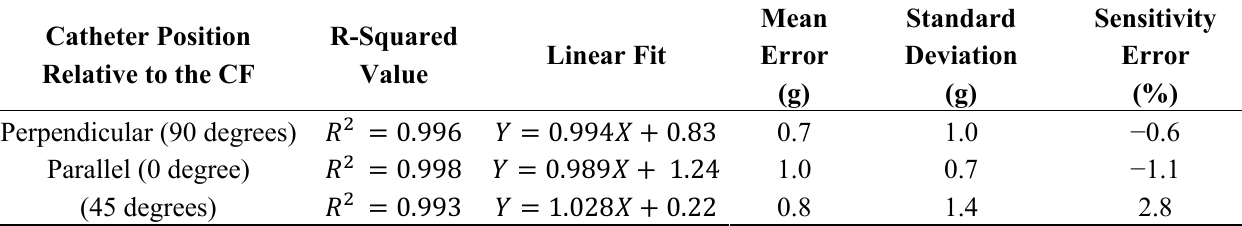
Table 3. Correlation between catheter tip CF calculated from FBG sensors as a function of measured force by certified